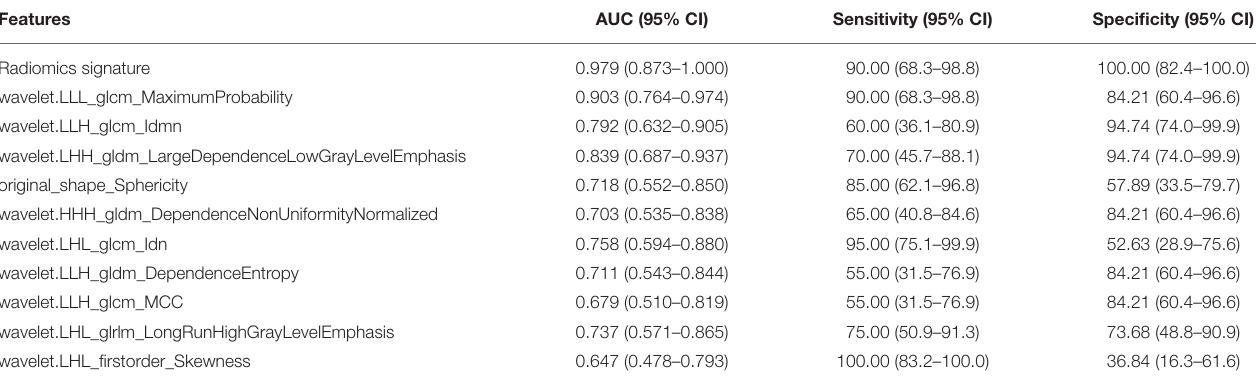
TABLE 3 | ROC analysis of the features selected from